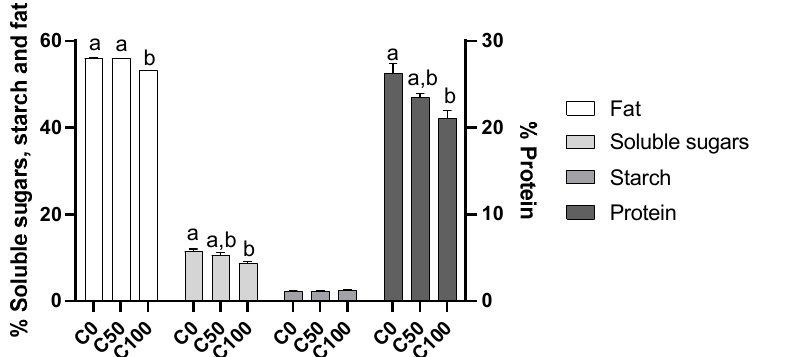
Figure 3. Chemical composition of almonds with or without the application of biostimulants. Different small letters (a,b) indicate significant differences at p < 0.05 according to the analysis of variance (ANOVA) and multiple range test (Tukey’s test). C0—control treatment with water; C50, Superfifty at 0.5 L/ha; C100, Superfifty at 1 L/ha.